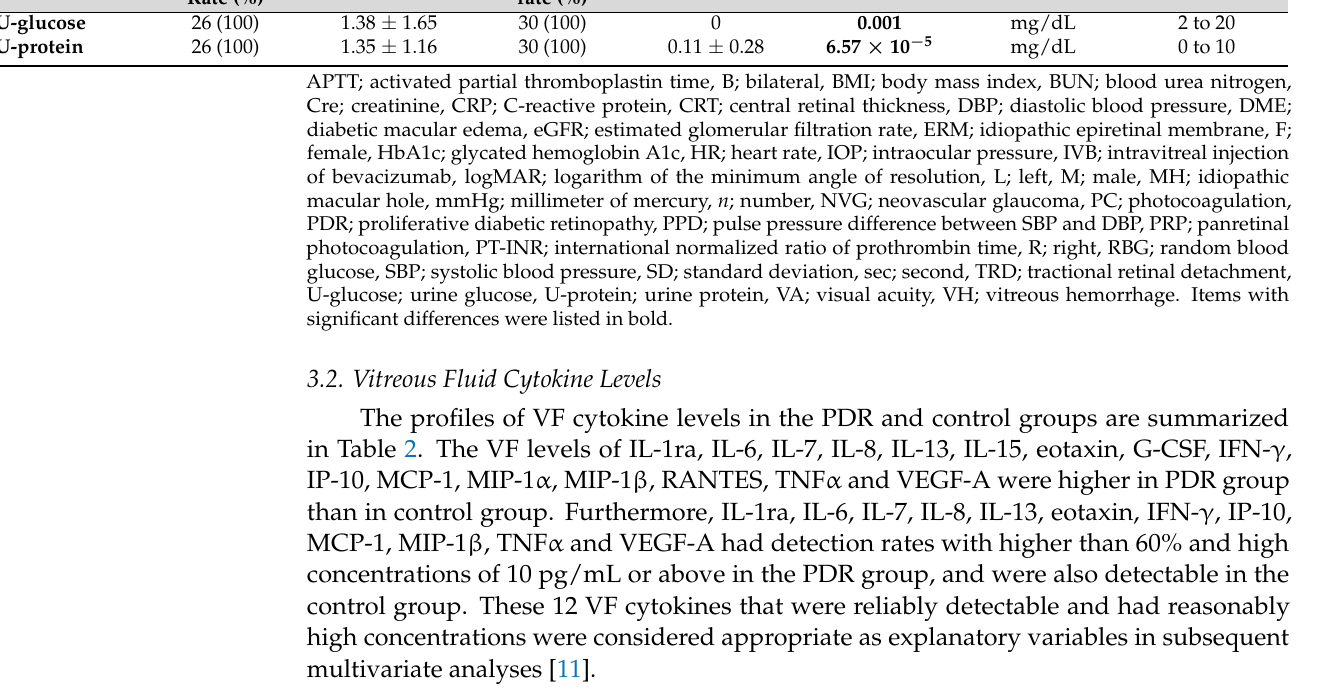
Table 2. Vitreous fluid levels of cytokines in PDR patients and